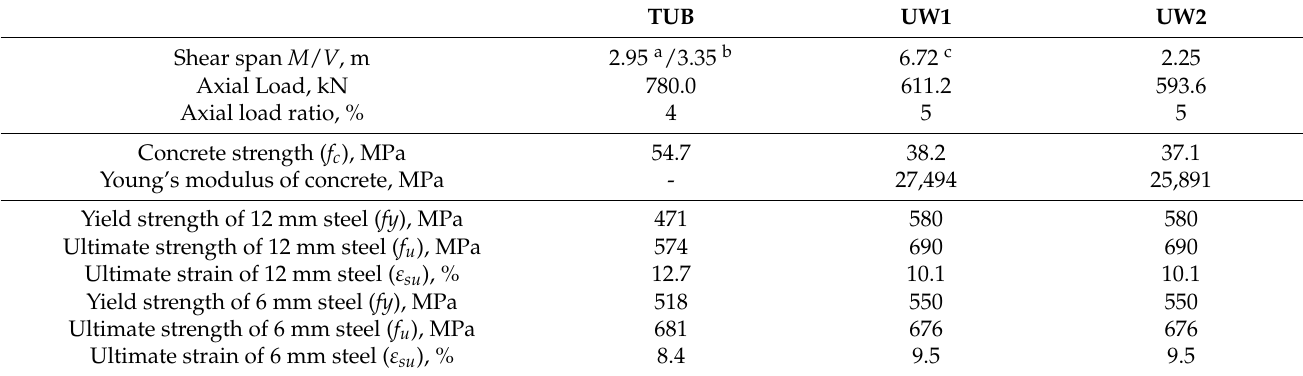
Figure 2. ( a ) Cross-section and reinforcement detailing of TUB [19], UW1, and UW2 [22], with dimensions in mm ( b ) loading positions for the test units. The superscripts “a” and “b” denote the different spacing or diameter of the rebar for units TUB and UW1/UW2, respectively. The positive (or plus “+”) signs indicate the experimental convention for positive direction of loading. Table 1. Comparison of wall parameters and material property values of wall